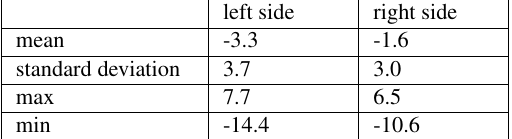
Table 2. Analysis of distance distributions (in